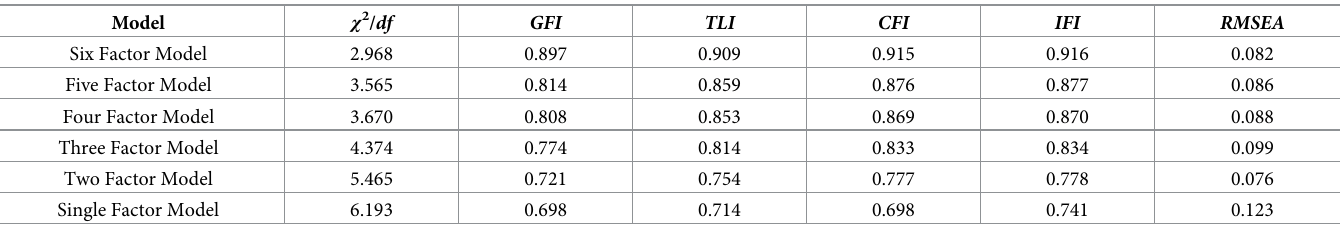
Table 4. Confirmatory factor analysis results of the scale.